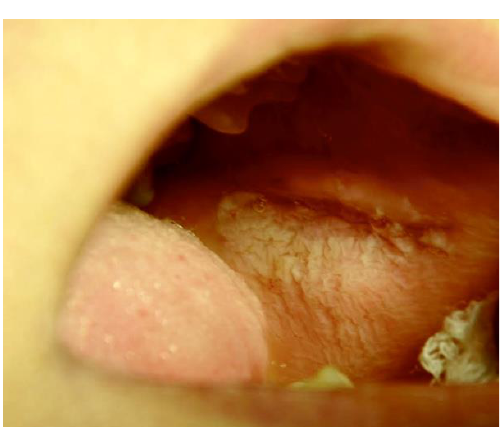
Figure 6. White lesion.